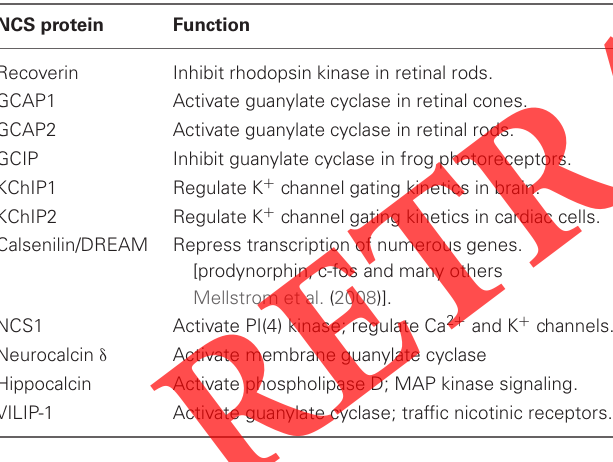
Table 1 | Function of NCS